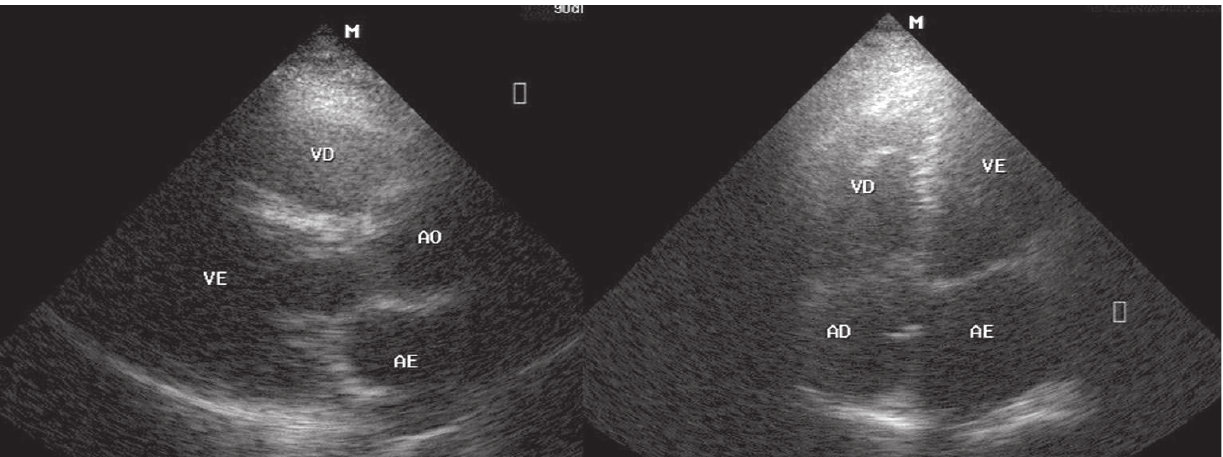
Fig. 2 - Ecocardiografia pós-operatória sem evidência de massas tumorais em átrio esquerdo. AD: átrio direito; AE: átrio esquerdo; AO: aorta; VD: ventrículo direito; VE: ventrículo esquerdo